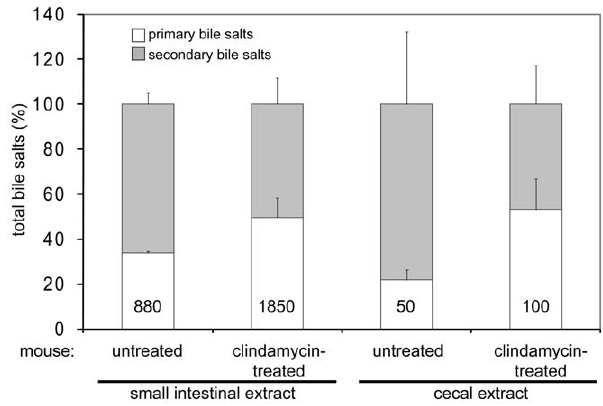
Figure 4. Proportions of primary bile salts in small intestinal and cecal extracts. Quantitation of bile salts in small intestinal and cecal extracts from untreated and clindamycin-treated mice was performed as previously described [23]. Data are reported as the mean percentages of total bile salts, with levels of primary bile salts ( m M) indicated in the bars and error bars representing the standard error of the mean.